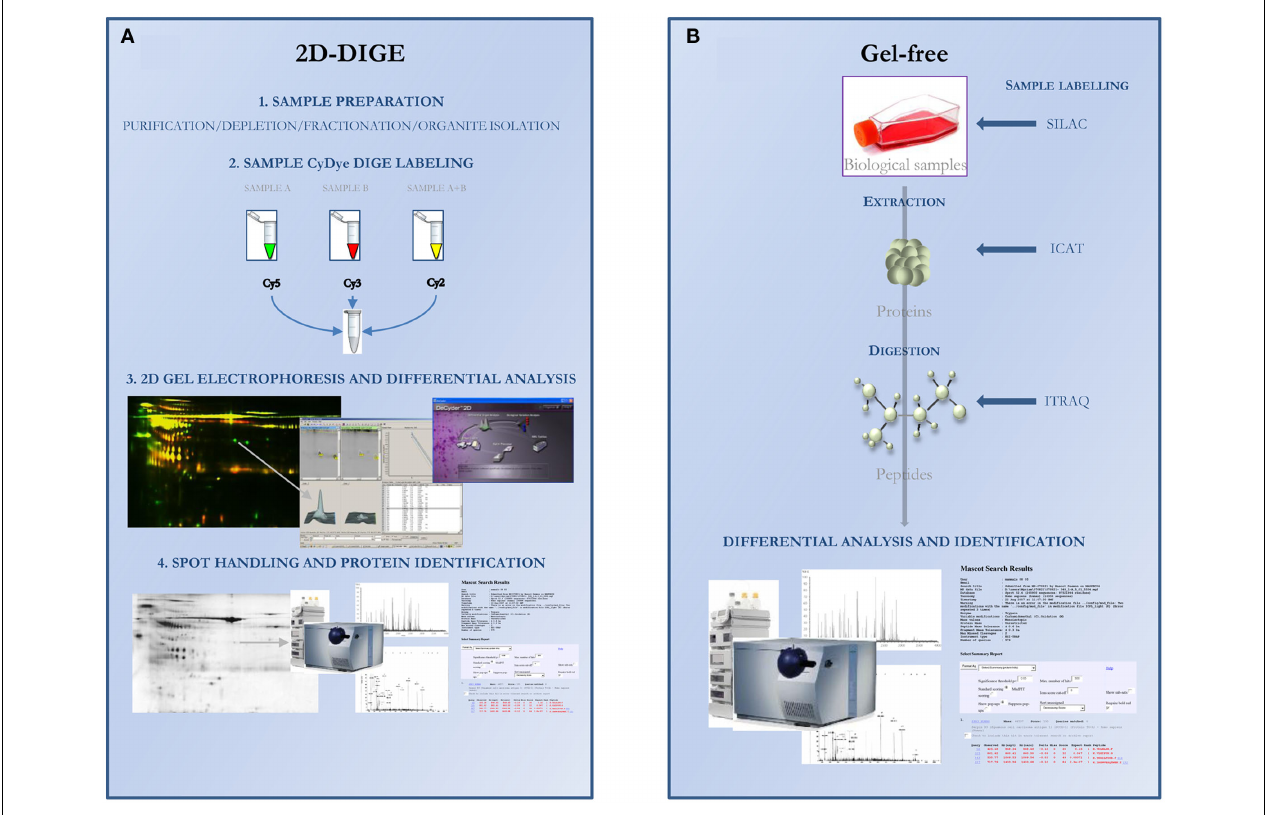
software and internal standard is used for normalization; (4) Differentially expressed protein spots are excised from a preparative gel and identified by mass spectrometry. (B) Gel-free approach. Proteins or peptides could be labeled at different stages of sample preparation depending on SILAC, ICAT, or iTRAQ technology. Light and heavy forms of isotopic analogs are resolved by 2D-LC and then quantified and identified by mass spectrometry. SILAC: stable isotope labeling by amino acid in cell culture; ICAT: isotope-coded affinity tag; iTRAQ: Isobaric tag for relative and absolute